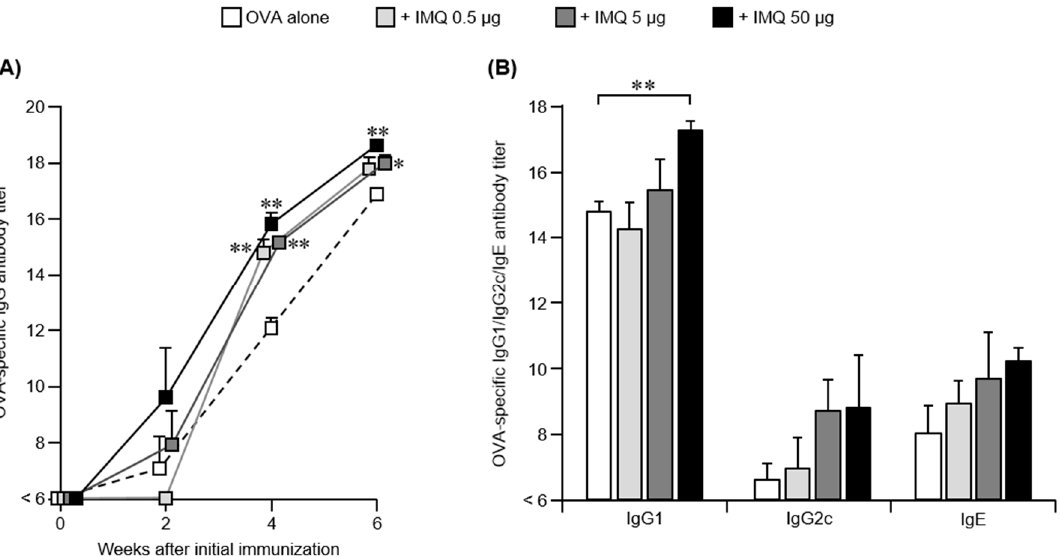
Figure 1. OVA-specific antibody production in combination with IMQ administration. C57BL/6 mice were immunized using the poke and patch method with OVA or OVA plus IMQ (0.5, 5, or 50 µ g) three times every 2 weeks. ( A ) Sera collected every 2 weeks were assayed to determine OVA-specific total IgG titers by ELISA analysis. ( B ) Sera collected 2 weeks after the last immunization were assayed to determine IgG subclass titers and IgE titers by ELISA. The data shown are expressed as the mean ± SE of the results from four mice (Williams’ test, * p < 0.05, ** p < 0.01, versus OVA alone).